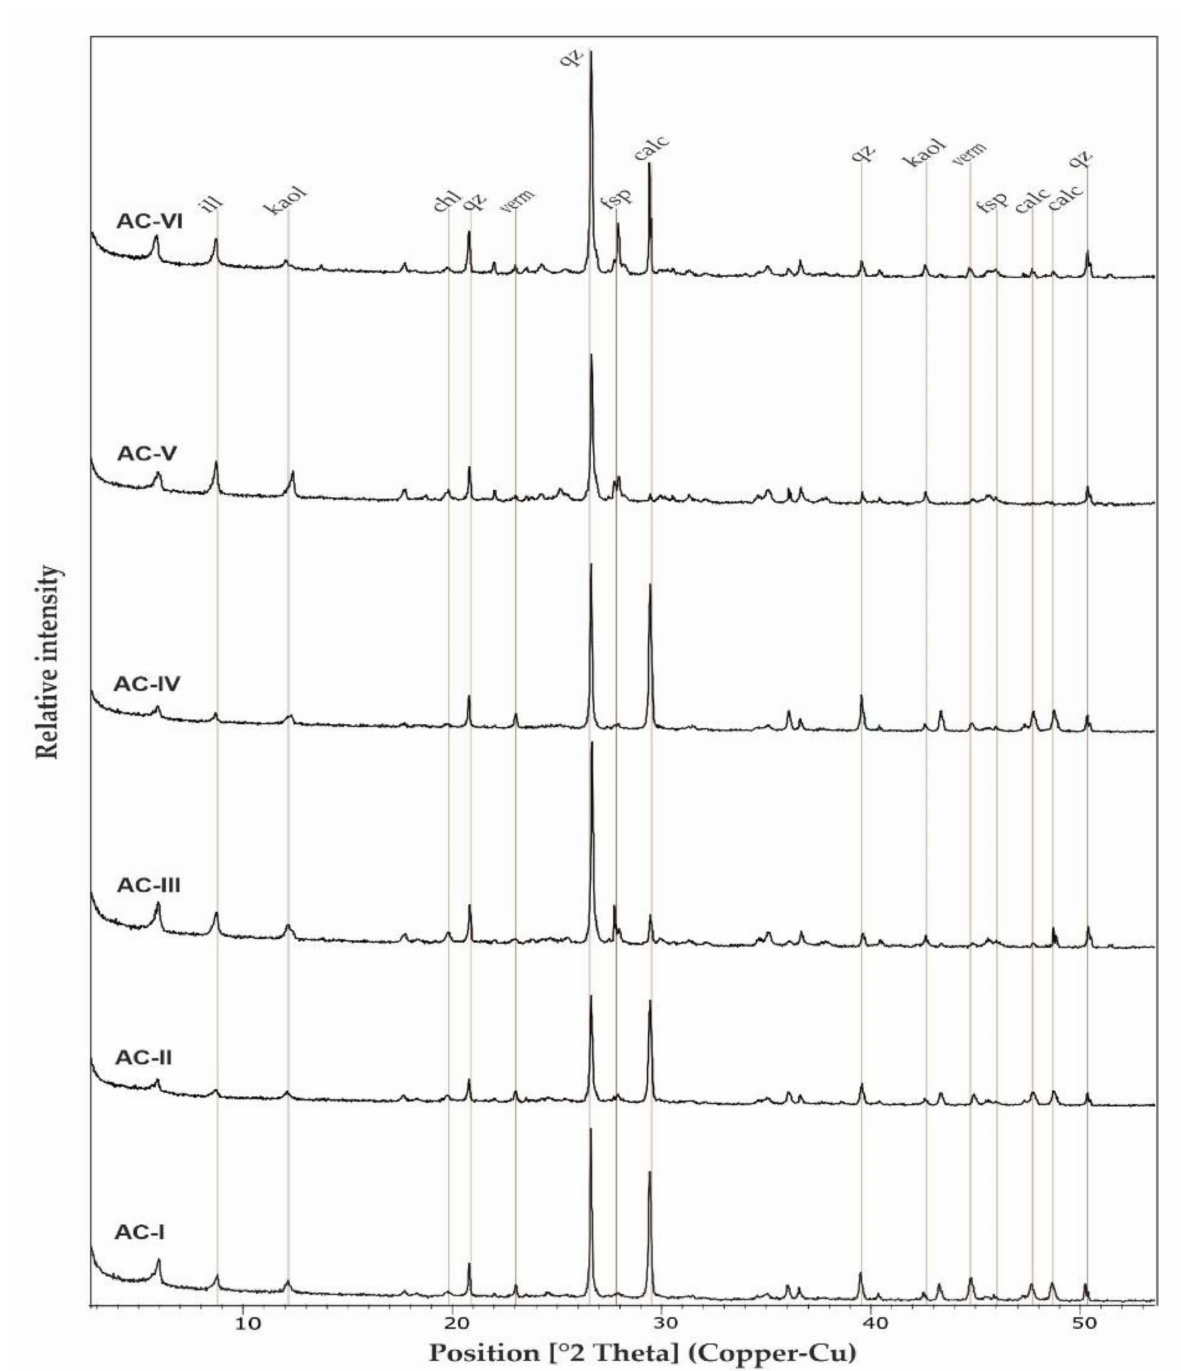
Figure 6. X-ray powder diffraction pattern of bulk rock samples: ill-illite, kaol-kaolinite, chl-chlorite, qz-quartz, verm- vermiculite, fsp-feldspar,